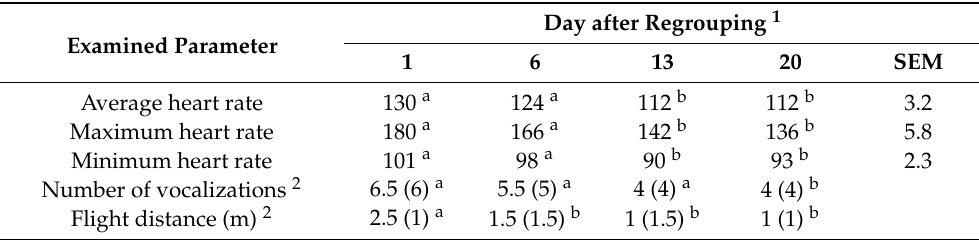
Table 4. Regrouping of different sheep breeds and effects on the average, minimum and maximum heart rate (beats/min), the number of escape attempts and vocalizations per min, and the flight distance (m) during the isolation—flight distance